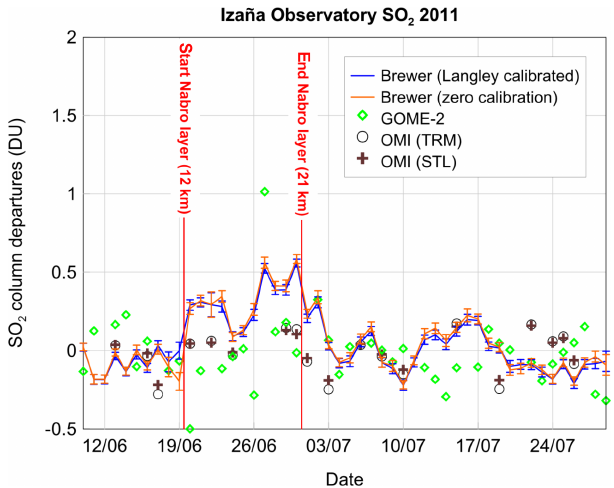
Figure 11. SO 2 column departures from the unperturbed 10-day pre-volcanic baseline measured by the Brewer, OMI (TRM, STL) and GOME-2 over Izaña, Tenerife, during June–July 2011 follow- ing the 2011 Nabro volcanic eruption. SO 2 calculations by the Brewer were performed using the Langley calibration and the zero calibration at Izaña (assuming SO 2 = 0 during the days 6 and 7 June